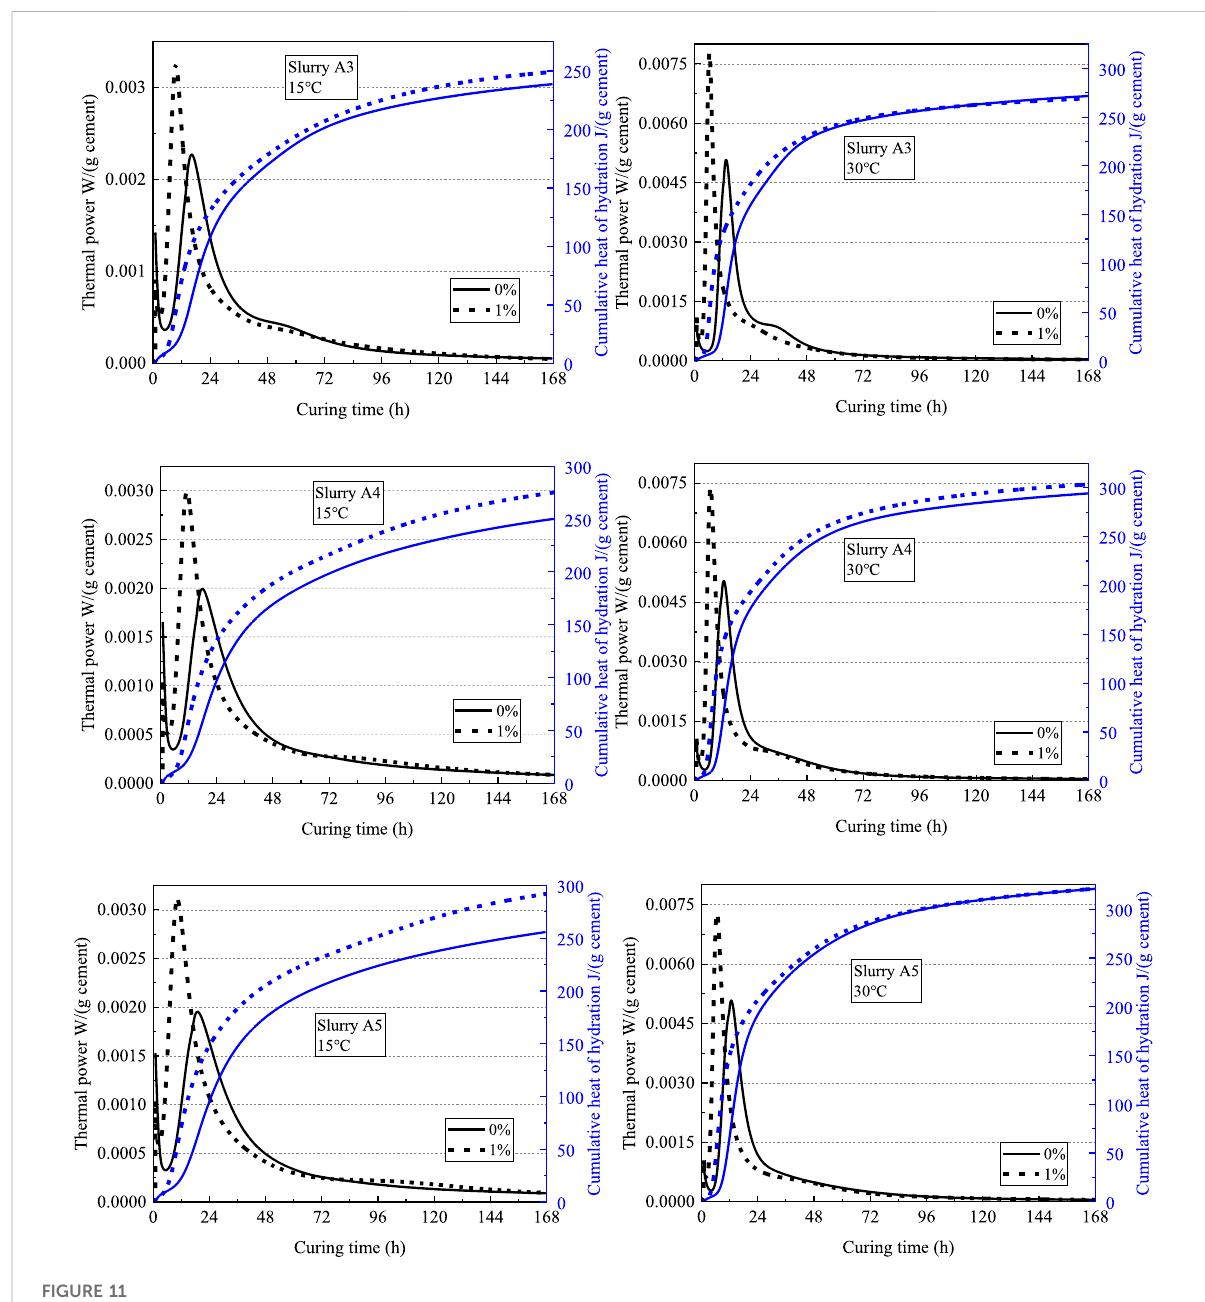
FIGURE 11 Effect of CaCl 2 dosages on the heat evolution curve for Aksu cement (left: 15 ° C; right: 30 ° C).